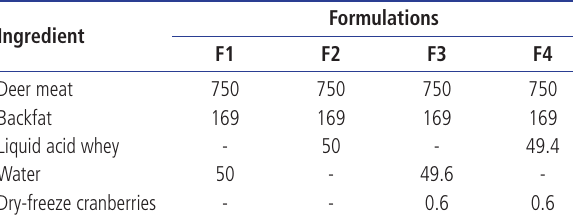
Table 1. Experimental design and ingredients used (g/kg of